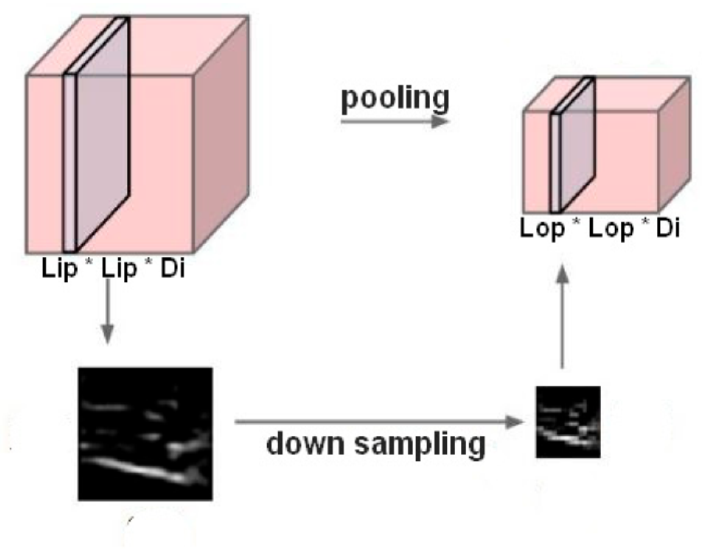
Figure 4. Input layer with several slices has been downsampled after pooling to reduce parameters and avoid overfitting